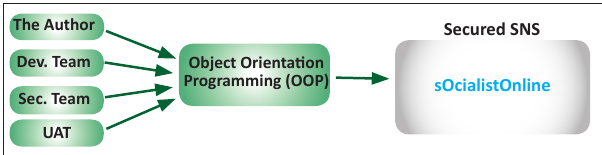
FIGURE 1: Development process for